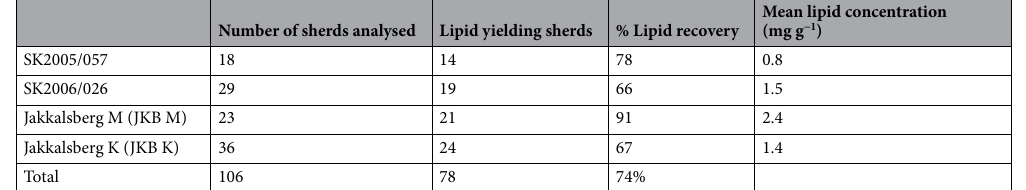
Table 2. Number of sherds analysed, number of lipid-yielding sherds, % lipid recovery, and mean lipid concentration (mg g −1 ), by site.